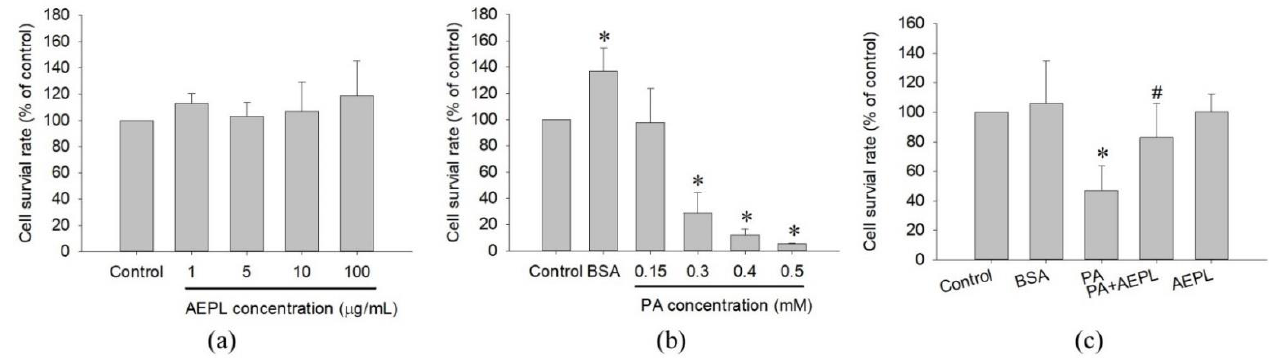
Figure 2. Cell toxicity test of AEPL ( a ) and PA ( b ) in various concentrations. ( c ) The cell viability of 0.3mM PA in presence or absence of 5 μg/mL AEPL for 24 h. All data were presented as mean ± SD of three independent experiments. * p < 0.05 vs. control cells; # p < 0.05 vs. PA-treated cells.